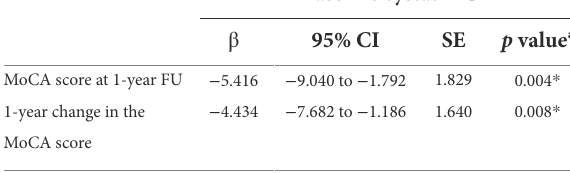
TABLE 2 The correlation between baseline cystatin C and cognition outcome in patients with MSA in multiple linear regression